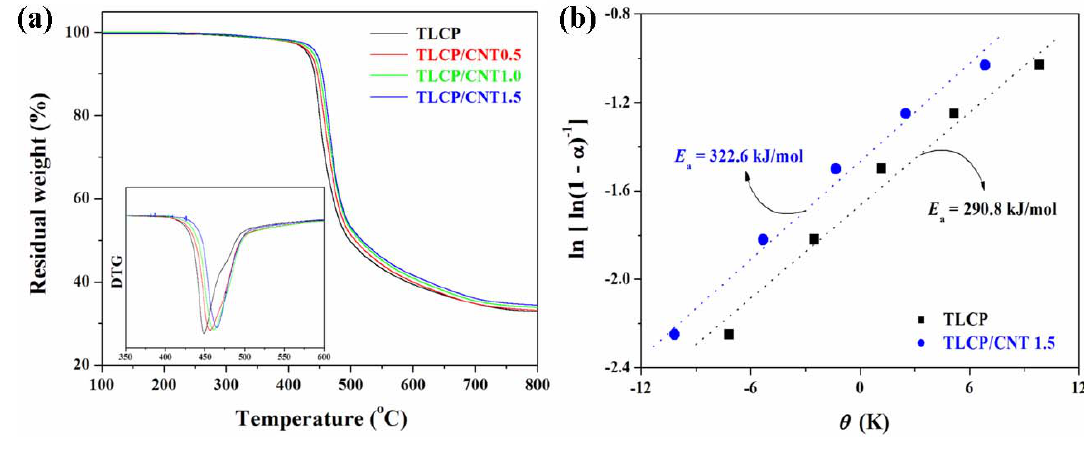
Figure 3. Thermal stability of TLCP nanocomposites. (a) TGA curves and (b) the plots of ln[ln(1- α ) -1 ] versus θ for TLCP nanocomposites. By Eq. (1), the slope provides an